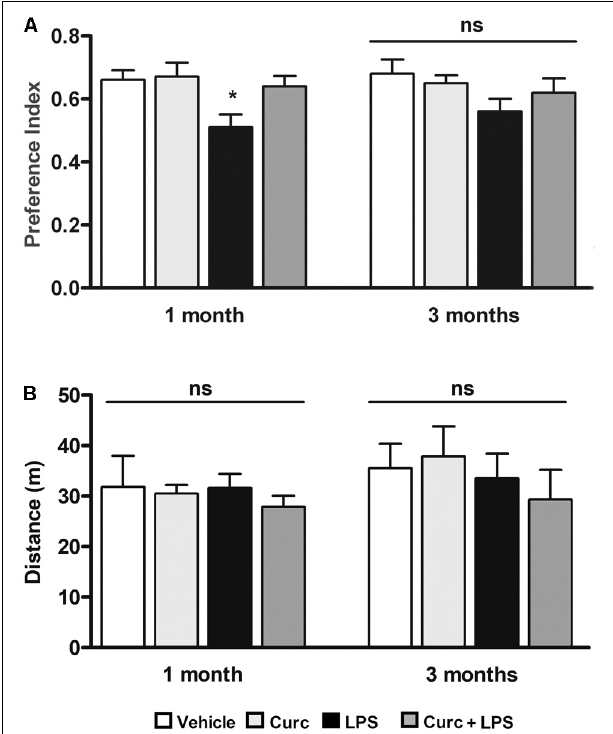
FIGURE 5 | Curcumin inhibits long-term memory deficits induced by peripheral LPS administration. Mice treated for 2 consecutive days with curcumin (curc; 50 mg/kg) received a single i.p. injection of LPS (5 mg/kg). (A) One and three months following LPS or saline injection, mice were subject to the novel object recognition test and the preference index, used as a recognition memory parameter, was calculated as described in Section “Materials and Methods.” Data are means ± SEM ( n = at least 7 mice/group). Data were analyzed by one-way ANOVA [ F ( 7 , 52 ) = 3.04, p = 0.0094] followed by Bonferroni’s multiple comparison test. ∗ p < 0.05 vs. control group. (B) One and three months following LPS or saline injection, mice were subject to the open field test to measure total distance traveled in the arena. Data are means ± SEM ( n = at least 7 mice/group). Data were analyzed by one-way ANOVA [ F ( 7 , 65 ) = 0.68, p = 0.69] followed by Bonferroni’s multiple comparison test. ns, not